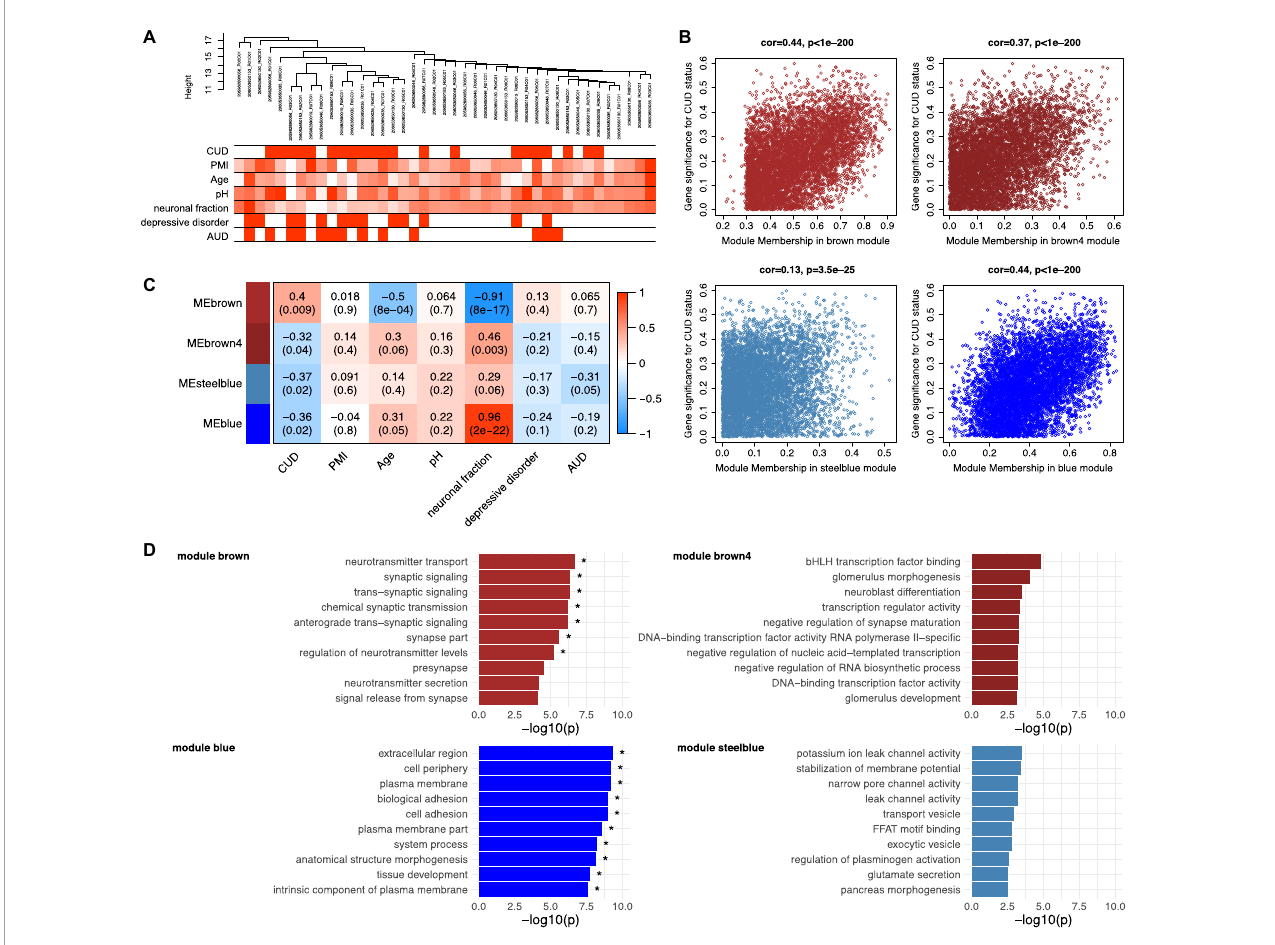
FIGURE3 Functional analysis of the CUD-associated co-methylation modules identified in WGCNA. Quantile-normalized beta values of methylation for N = 117,876 promoter-associated cytosine-phosphate-guanine (CpG) sites (TSS200 and TSS1500) were extracted and used as an input dataset for WGCNA. (A) Dendrogram of hierarchical sample clustering with trait annotation. (B) Correlation plots of module membership and CUD gene significance for the four CUD-associated co-methylation modules (brown, brown4, steelblue, blue). (C) Module-trait relationships for the CUD-associated modules. Module-trait correlation coefficients are color-coded, and correlation p -values are shown in brackets. (D) Results of the Gene Ontology (GO) enrichment analysis. The 10 GO terms with the strongest enrichment within the respective co-methylation module are displayed (* = FDR < 0.05). CUD, cocaine use disorder; PMI, post-mortem interval; neuronal fraction, estimated neuronal cell type proportion based on Houseman et al. (37); AUD, alcohol use